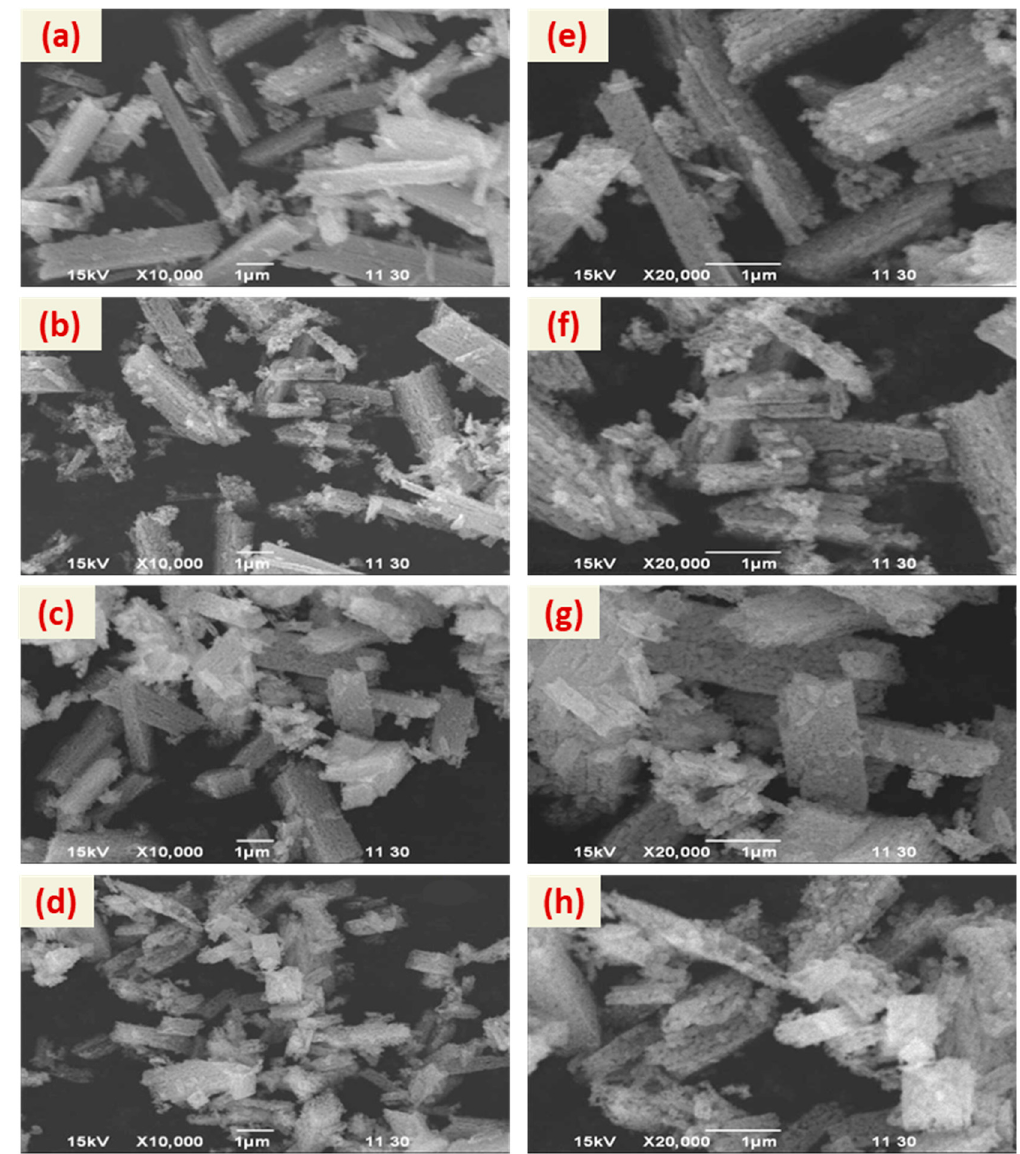
Figure 3. SEM images with different magnifications ( a,e ) ZnO, ( b,f ) 1% N/ZnO, ( c,g ) 5% N/ZnO and ( d,h ) 7% N/ZnO.